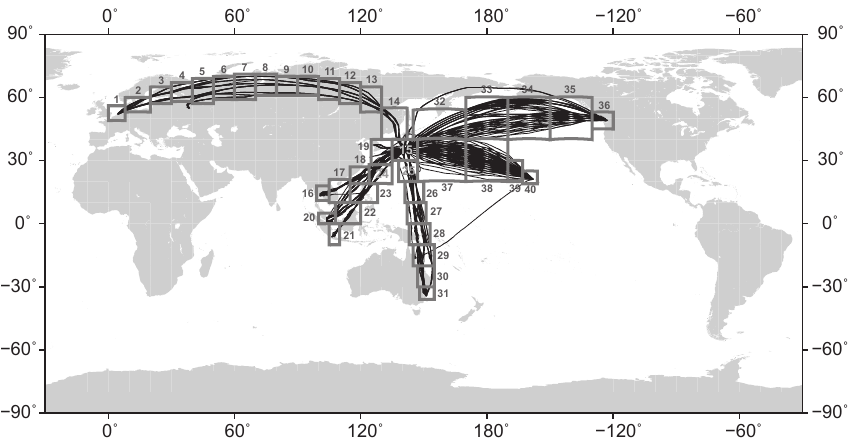
Figure 2. Flight tracks of all of the CONTRAIL CME observations in 2010 used in this study. The number next to each box area indicates its area